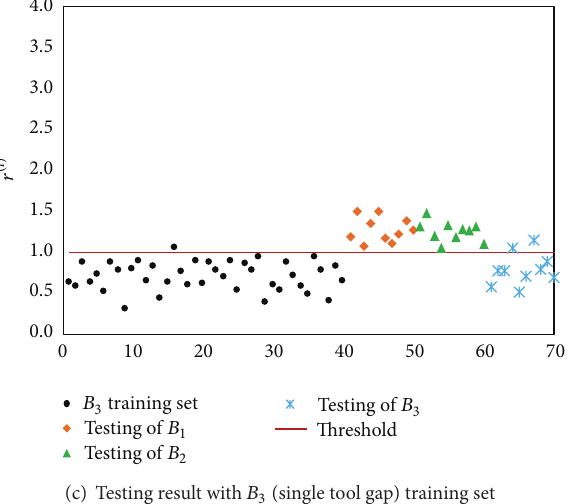
Figure 8: Test results of three classes with standard KPCA-MFD- 𝑘 NN